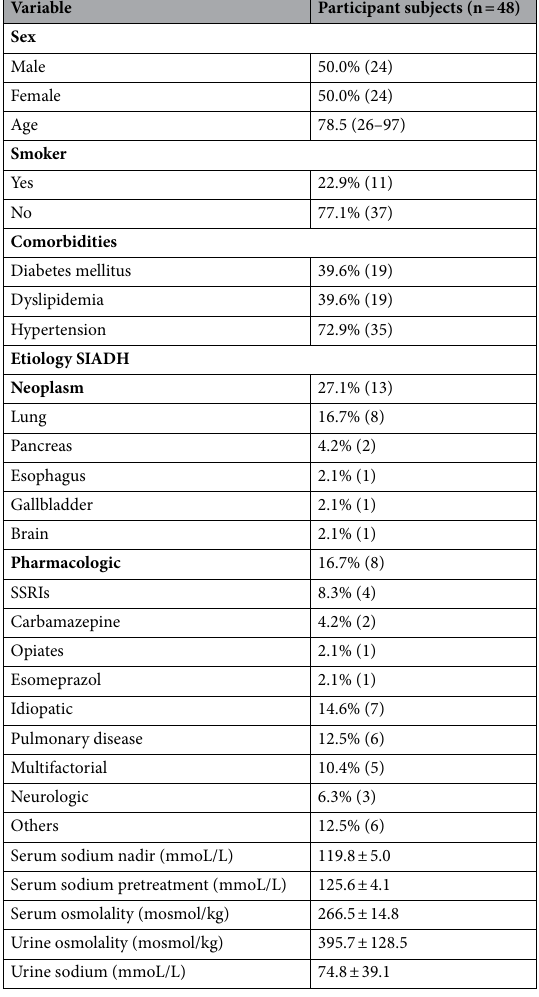
Table 2. Basal characteristics of the patients. Age is expressed as median (range). Other cuantitative variables are expressed as mean ± standard deviation. Cualitative variables are expressed as % (n). SSRIs selective serotonin reuptake